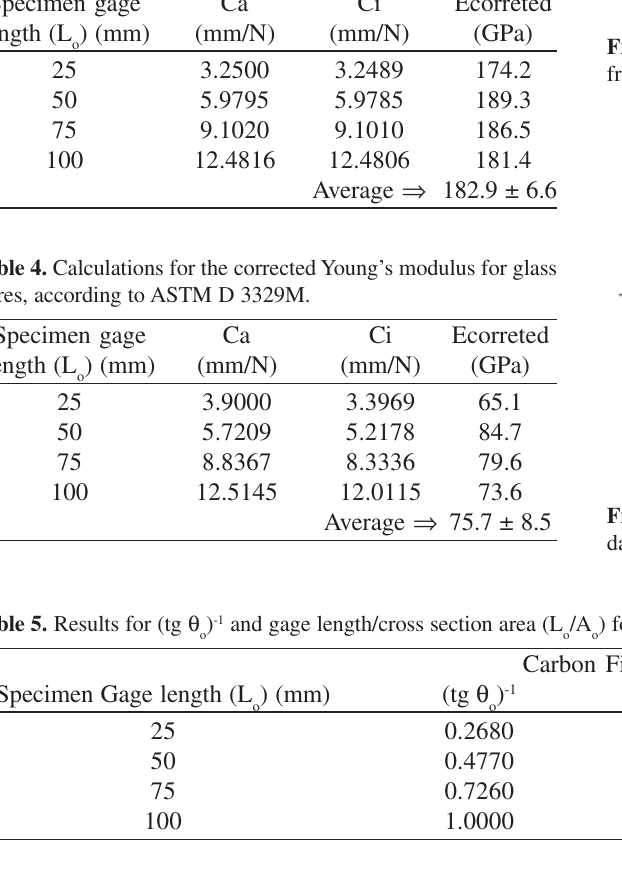
Table 3. Calculations for the corrected Young’s modulus for car- bon fibres, according to ASTM D 3329M.